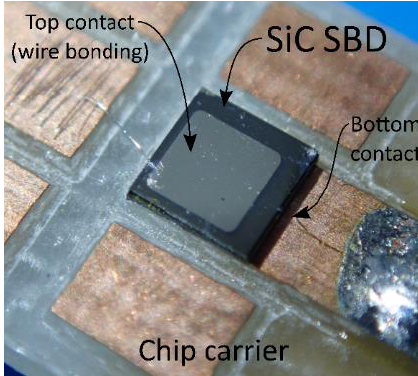
Figure 2: Close-up photograph of a SiC Schottky Barrier Diode (black), mounted and connected to the chip carrier. The light grey square on the diode surface is the top Schottky electrode (2mm × 2mm), defining the active volume of the detector.